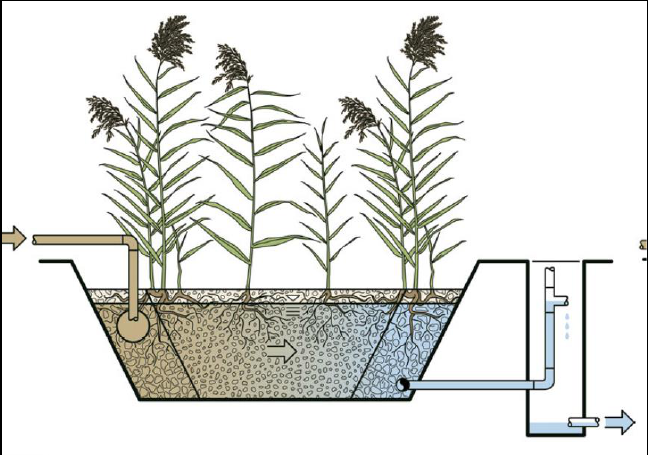
Figure 2. Subsurface vertical flow VFCW [7].